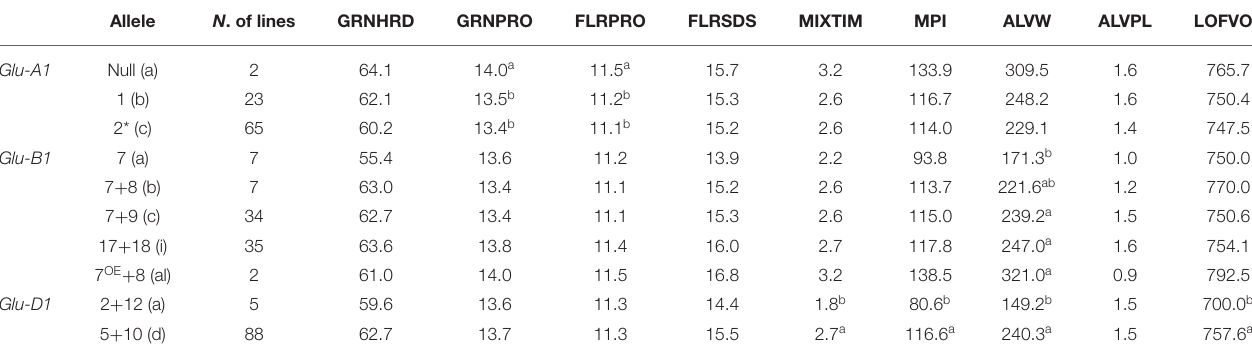
GRNHRD, grain hardness; GRNPRO, grain protein; FLRPRO, flour protein; FLRSDS, flour SDS-sedimentation volume; MIXTIM, mixograph optimum mixing time; MLP, mixograph MPI; ALVW, alveograph work; ALVPL, alveograph tenacity/extensibility ratio; LOFVOL, bread loaf volume. Values with different letters are significantly different (p < 0.05) according to Fisher’s protected least significant differences.